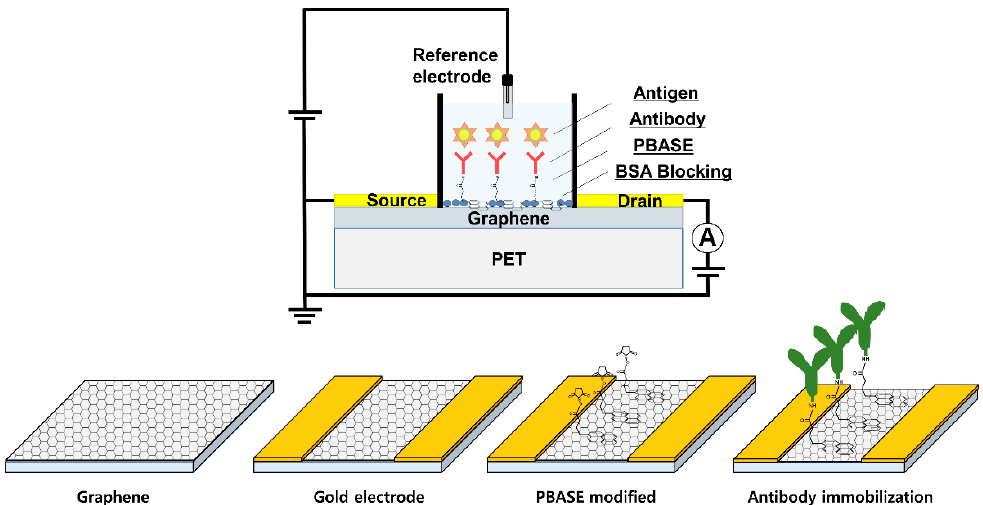
Figure 1. Schematic illustration of AFP detection using G-FET and modification process.